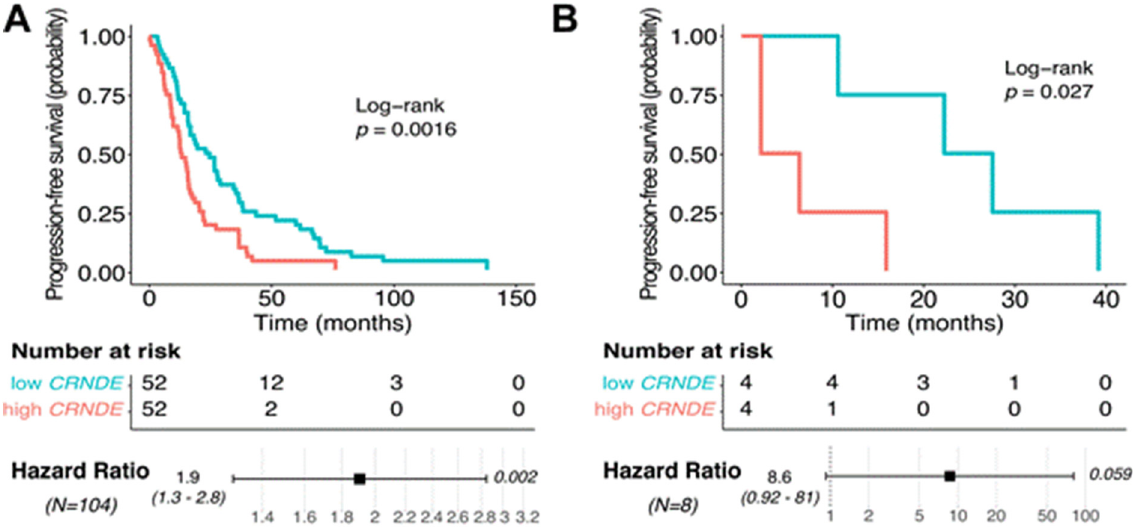
Figure 10. Kaplan–Meier plot and hazard ratio for CRNDE expression in glioblastoma samples across ( A ) TCGA and ( B ) Slovenia datasets for progression–free survival (PFS) analysis .